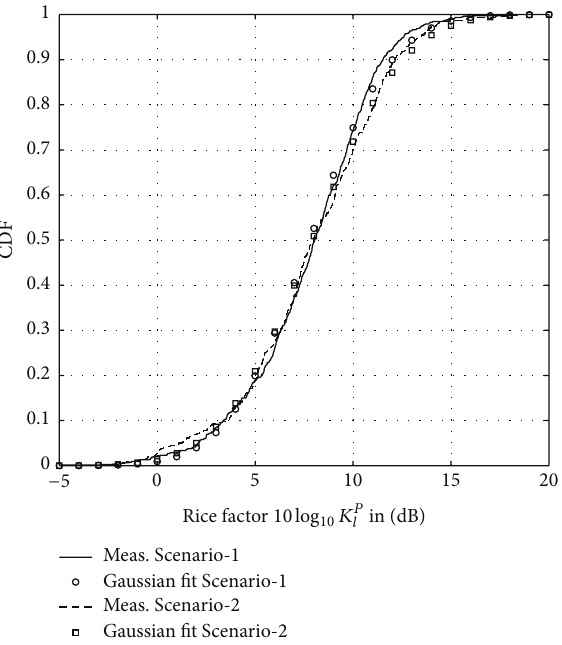
Figure 14: CDF of estimated Rice factors. The 𝑝 values obtained by the KS test are 0.3 and 0.52 for Scenario-1 and Scenario-2, respectively.